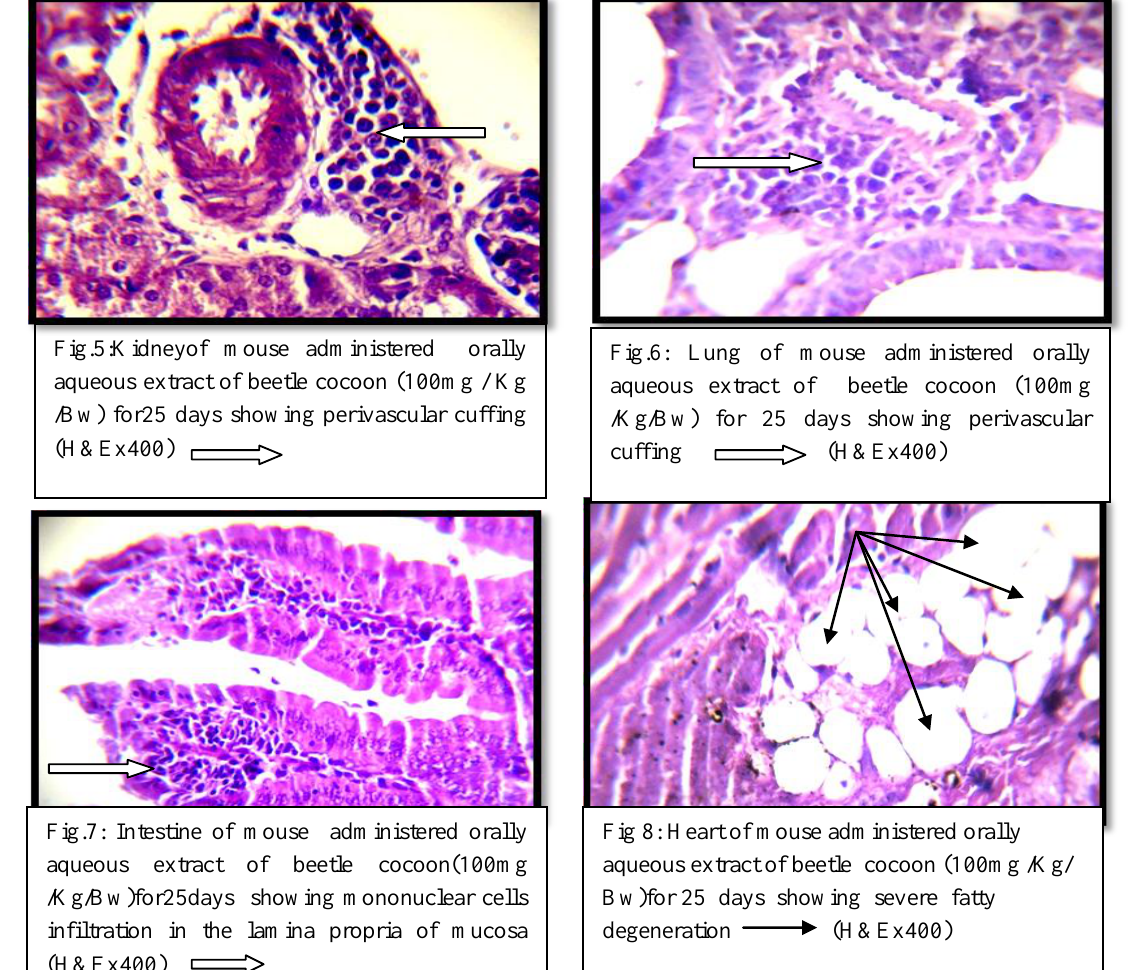
Fig 8: Heart of mouse administered orally aqueous extract of beetle cocoon (100mg /Kg/ Bw)for 25 days showing severe fatty degeneration (H&Ex400)